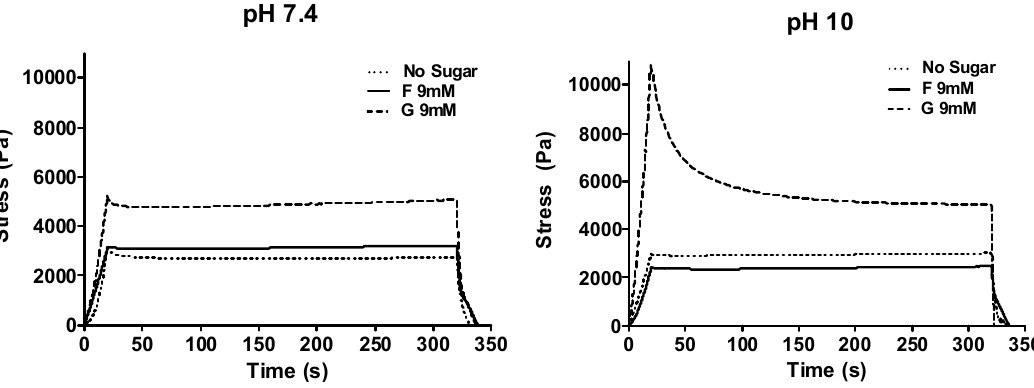
Figure 3. Engineering stress records for p(AAM- co -MPBA) hydrogels following compression to 90% of original thickness. F and G denote fructose and glucose, respectively.